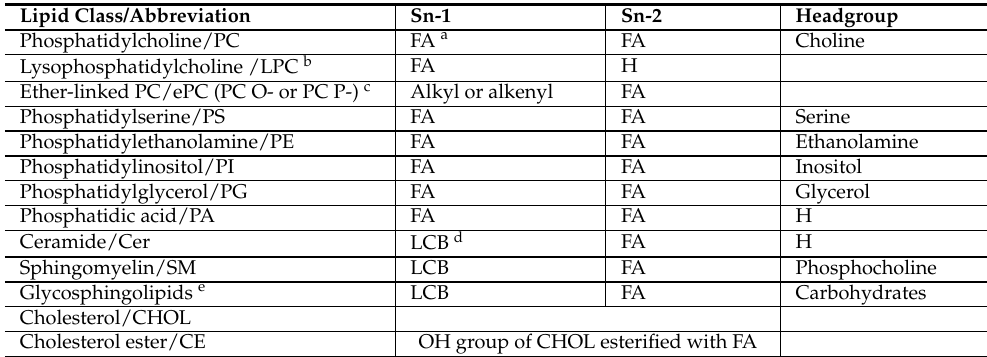
Table 1. Most common lipid classes in biological membranes. Table adapted from Skotland et al. [11]. Lipid